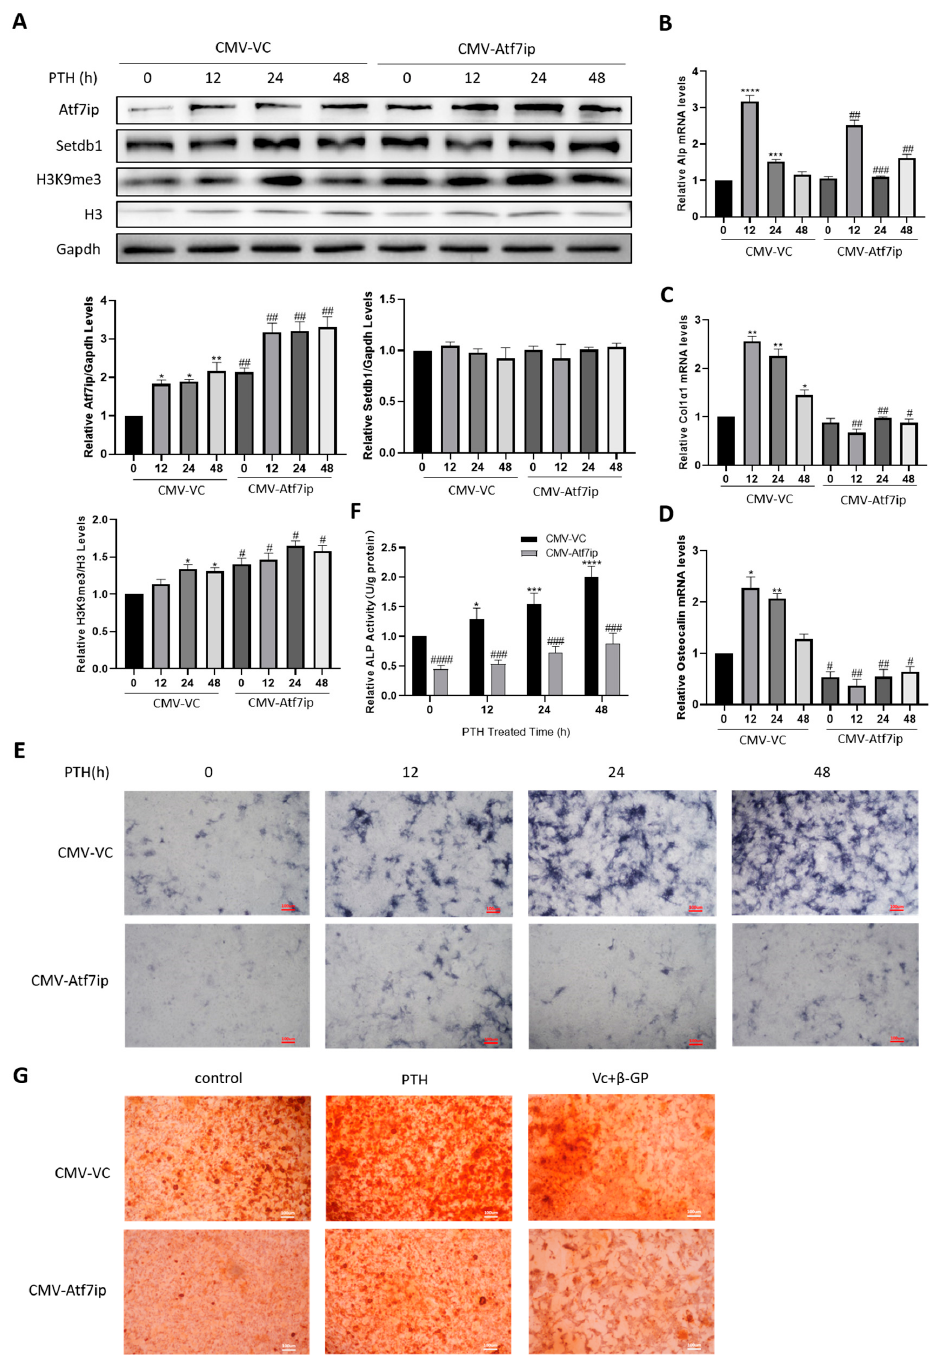
Figure 3. Overexpression of Atf7ip inhibits the osteogenic differentiation of MC3T3-E1 cells. The cells were first transiently transfected with the Atf7ip overexpression vector (CMV-Atf7ip) or its vector control (CMV-VC) for 24 h, and were then treated with 500 ng/mL PTH for the indicated time. The protein ( A ) and RNA ( B – D ) were collected to analyze the expression levels of the target molecules. n = 3. Alkaline phosphatase staining ( E ) and Alp activity assay ( F ). ( G ) Alizarin red staining of Atf7ip overexpression cells with PTH or osteoblast differentiation culture for 7 days. The experiments were repeated at least three times. Scale bar, 100 µ m. Data are expressed as mean ± SD. The significance was measured by one-way ANOVA, * p < 0.05, ** p < 0.01, *** p < 0.001 **** p < 0.0001, treatments vs. no treatment; # p < 0.05, ## p < 0.01, ### p < 0.001, #### p < 0.0001, CMV-Atf7ip vs.